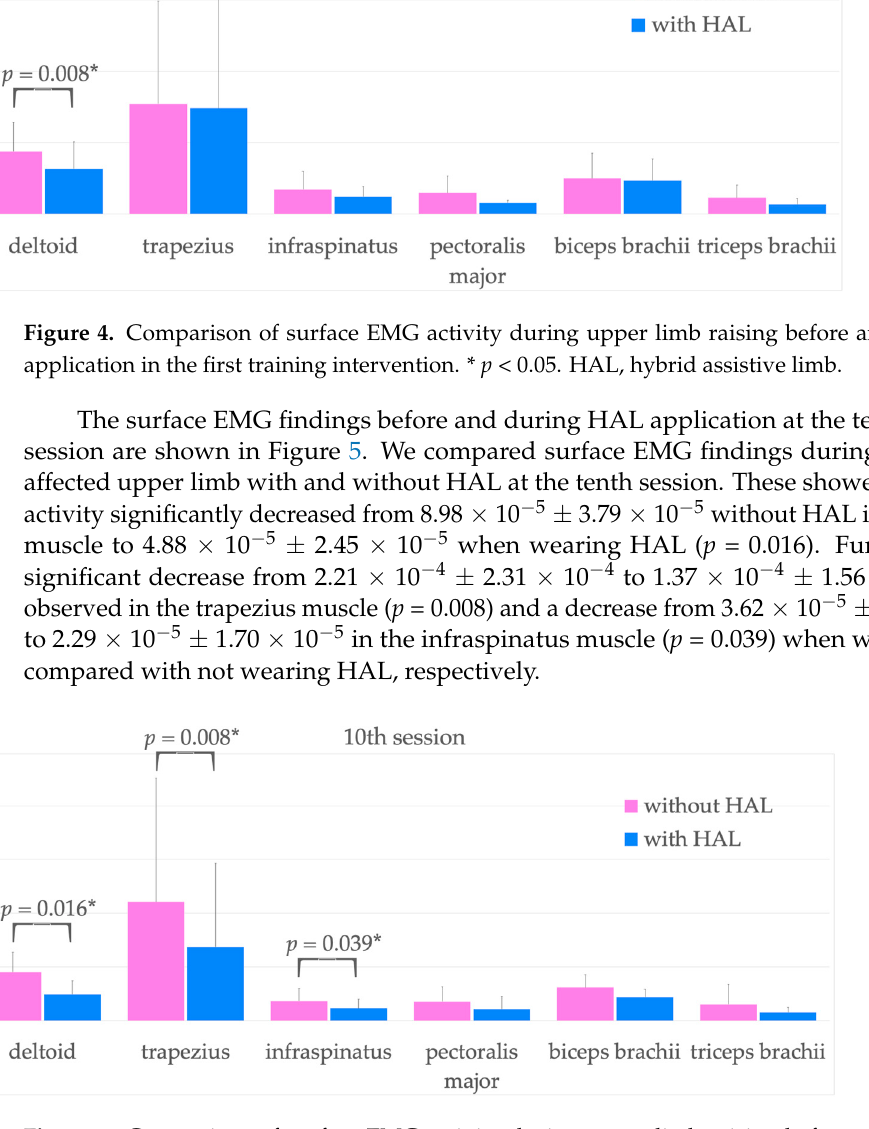
( b ) Figure 3. Shoulder joint ROM pre ‐ and post ‐ intervention. ( a ) Voluntary shoulder joint range of mo ‐ tion pre ‐ and post ‐ intervention, ( b ) passive shoulder joint ROM pre ‐ and post ‐ intervention. * Indi ‐ cates p < 0.05. ROM, range of motion. Pre ‐ intervention, all eight patients had an MMT score of 2 for both flexion move ‐